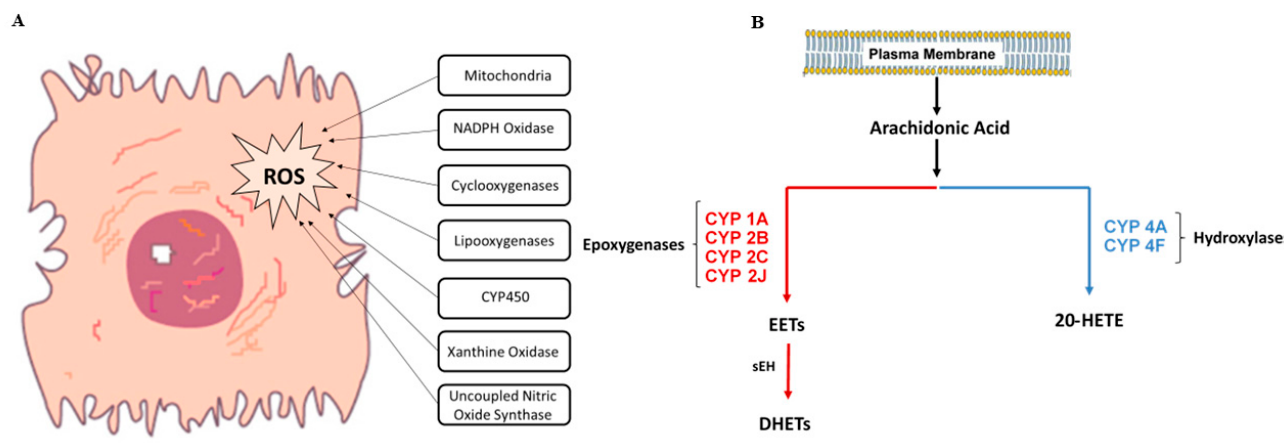
Figure 1. ( A ) Sources of reactive oxygen species in cells. ( B ) Pathways of arachidonic acid metabolism. Free arachidonic acid is metabolized via the CYP450 enzymes CYP1A, CYP2B, CYP2C, and CYP2J (which belong to the epoxigenase family) to produce EETs, and via the CYP4A or CYP4F enzymes (which belong to the hydroxylase family) to produce 20-HETE. ROS: reactive oxygen species; EETs: epoxyeicosatrienoic acids; sEH: soluble epoxide hydrolase; DHETs: dihydroxyeicosatrienoic acids; 20-HETE: 20-hydroxyeicosatetraenoic acid The major products of the CYP450-catalyzed arachidonic acid monooxygenase path- way are regiospecific and stereospecific epoxyeicosatrienoic acids (EETs) and their